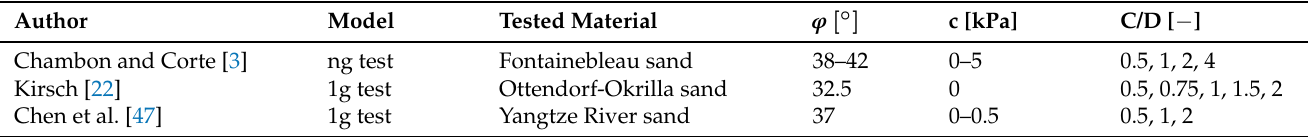
Table 1. Selected physical model tests for he verification of tunnel face stability